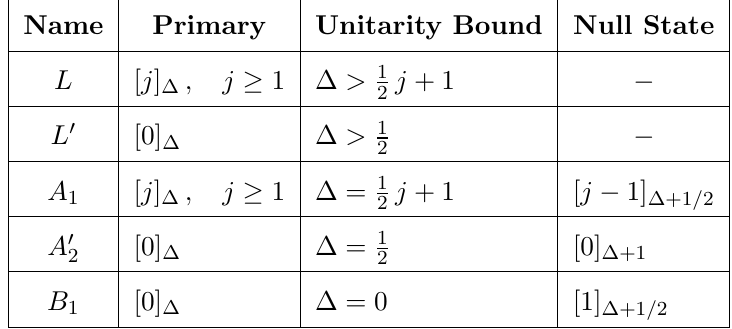
Table 1 . Shortening conditions in three-dimensional N = 1